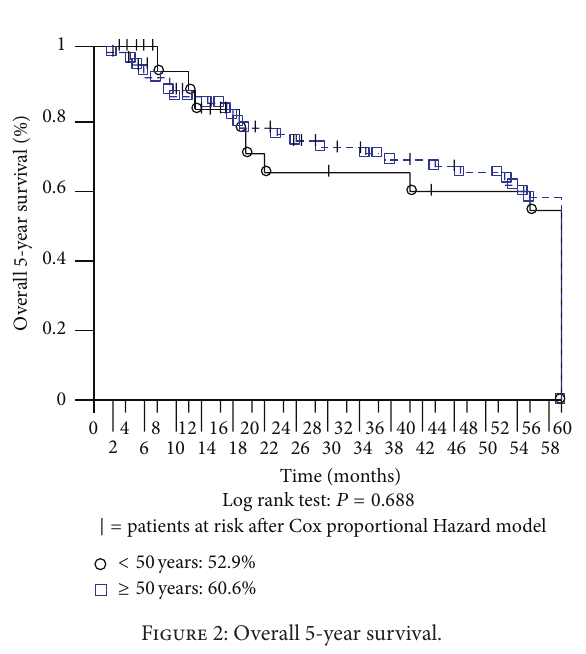
Figure 2: Overall 5-year